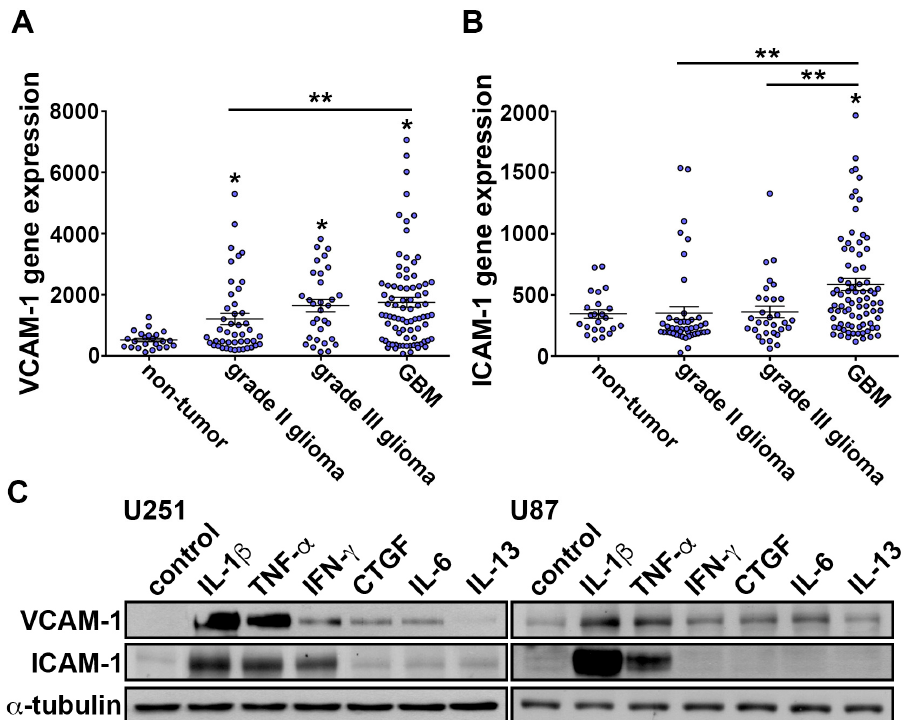
Figure 1. VCAM-1 and ICAM-1 levels correlated with the glioma clinico-pathological grade. ( A ) Messenger RNA levels of VCAM-1 in specimens of glioma patients that were obtained from GSE4290 datasets. The data are presented as mean ± S.E.M * p < 0.05 compared with the non-tumor group. ** p < 0.05 grade II glioma group compared with the GBM group. ( B ) Messenger RNA levels of ICAM-1 in specimens from glioma patients that were obtained from GSE4290 datasets. The values are presented as mean ± S.E.M. * p < 0.05 compared with the non-tumor group. ** p < 0.05 grade II and grade III glioma group compared with the GBM group. ( C ) U251 and U87 cells were added with IL-1 β (10 ng / mL), TNF- α (10 ng / mL), IFN- γ (50 ng / mL), CTGF (100 ng / mL), IL-6 (10 ng / mL) or IL-13 (10 ng / mL) cytokines for 24 h. The expressions levels of ICAM-1 and VCAM-1 were analyzed using western